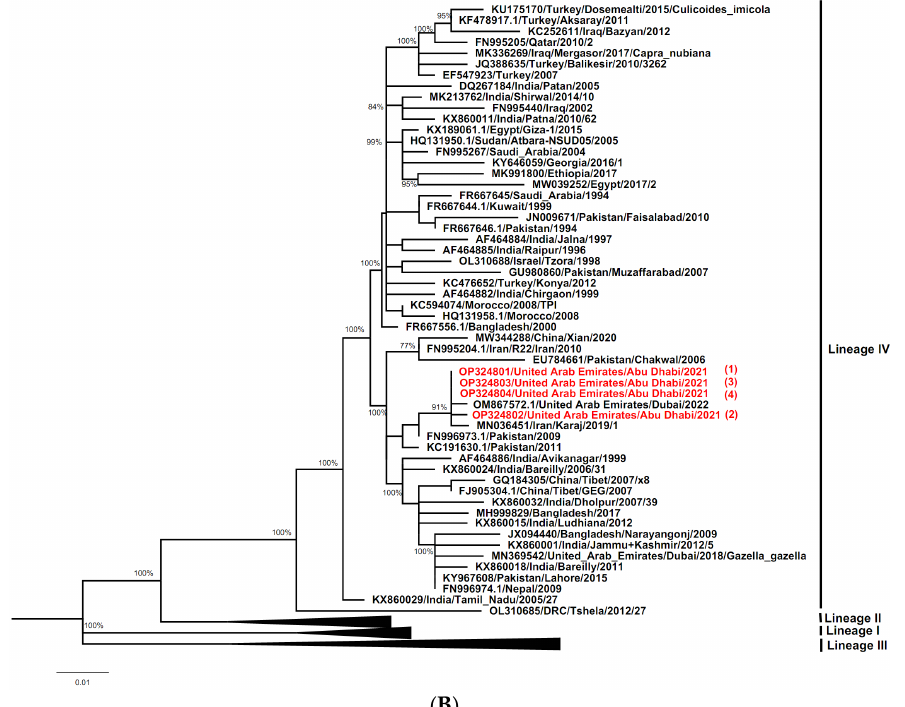
Figure 5. ( A ) Phylogenetic relationship between PPRV detected in the UAE in goats and dama gazelle and other virus isolates sequences described in method section. The tree was constructed based on the N gene (255 bp), using the Maximum Likelihood method and General Time Reversible model [39] in MEGAX [38]. Alignments were calculated with ClustalW [37] impeded in MEGAX. Bootstrapping (values indicated in %) was performed with 1000 replicates. The sequences obtained in this study clustered within Asian lineage IV and are marked with red color (numbered from 1–4). ( B ) Phylogenetic relationship between PPRV detected in UAE in goats and dama gazelle and other virus isolates sequences described in method section. The tree was constructed based on the F gene (322 bp), using the Maximum Likelihood method and General Time Reversible model [39] in MEGAX [38]. Alignments were calculated with ClustalW [37] impeded in MEGAX. Bootstrapping (values indicated in %) was performed with 1000 replicates. The sequences obtained in this study clustered within Asian lineage IV and are marked in red (numbered from 1–4).